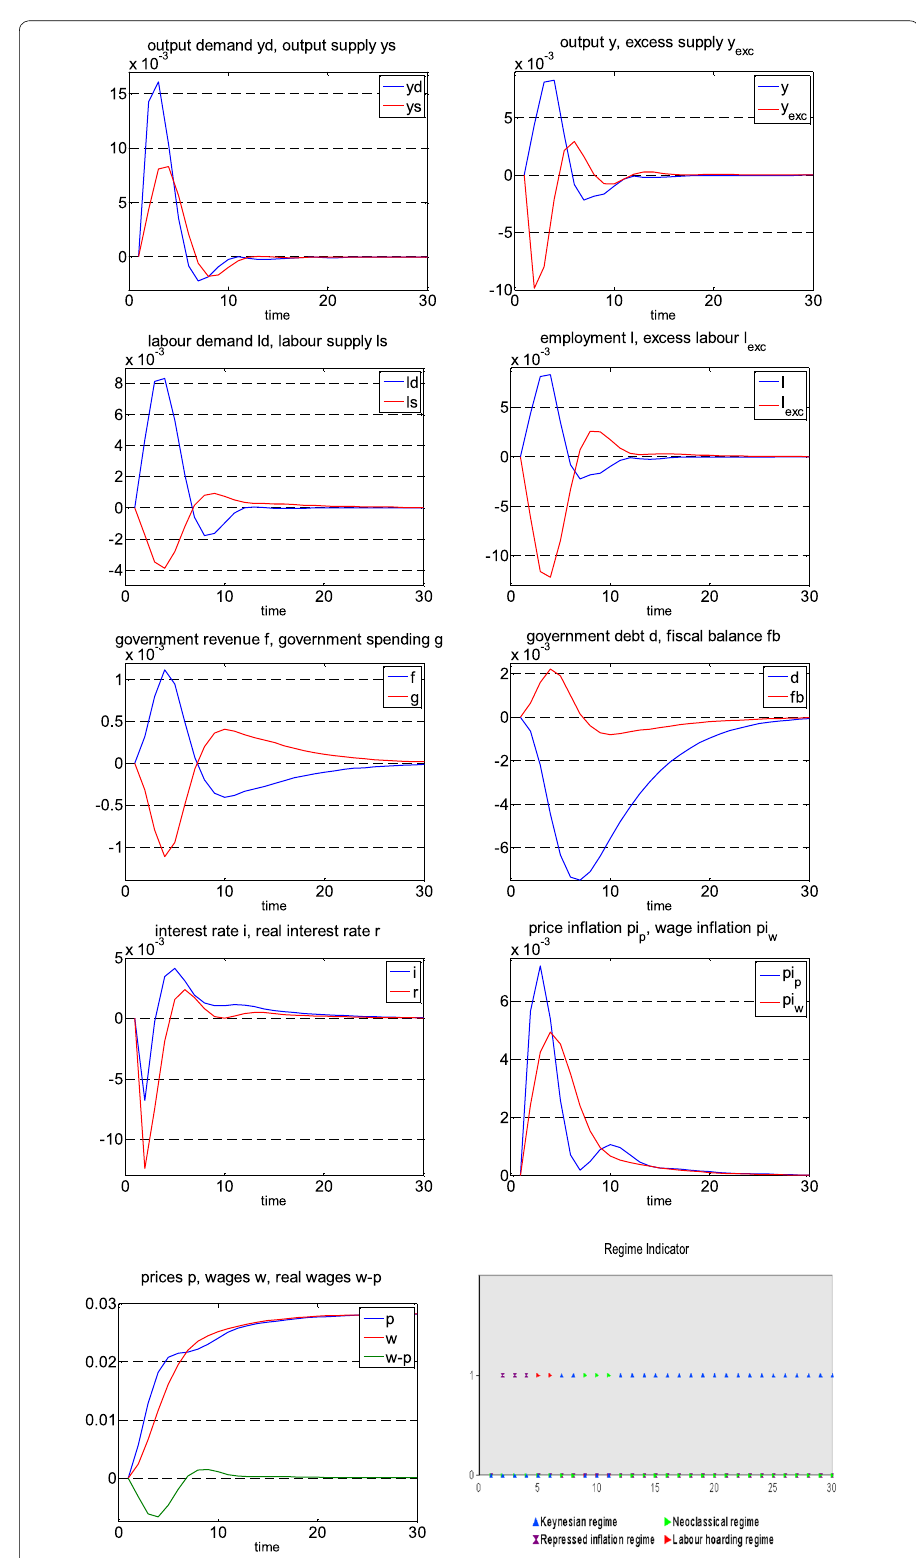
Fig. 2 Effects of a one-time negative interest rate